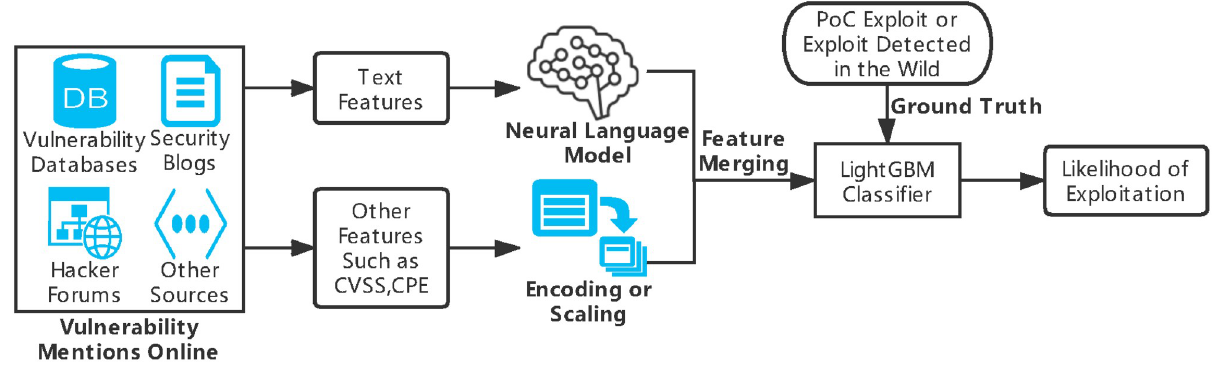
Fig 1. Overview of